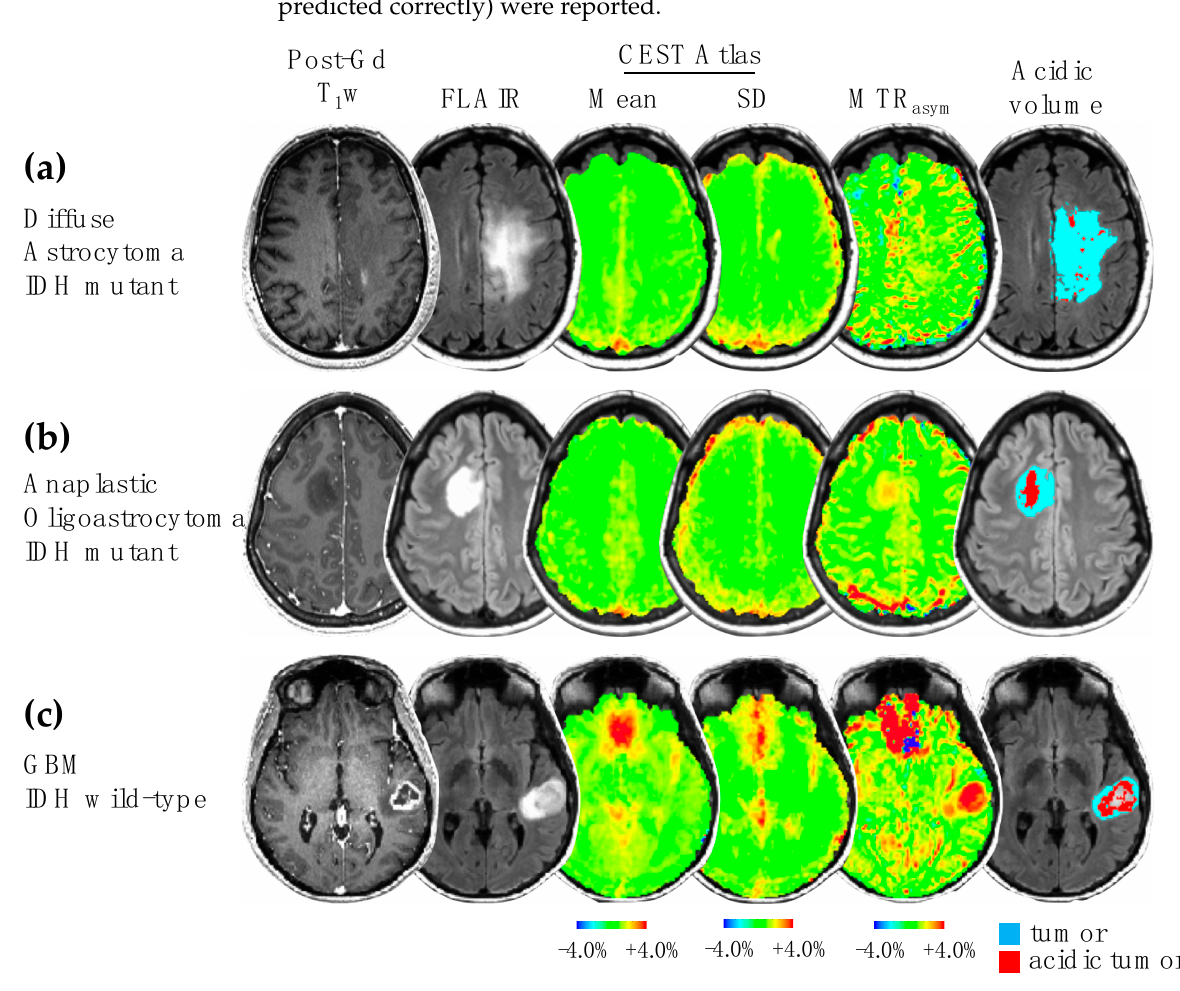
Figure 2. Examples of acidic volume determination with CEST atlas. Three patient examples with glioma grade II ( a ), grade III ( b ), and grade IV ( c ) are demonstrated, showing post-contrast T 1 -weighted image, FLAIR image, CEST atlas, MTR asym at 3.0 ppm, and the acidic volume within the tumor. The high MTR asym in the frontal brain region in patient ( c ) was due to an artifact caused by large B 0 inhomogeneity in this region. SD: standard deviation.